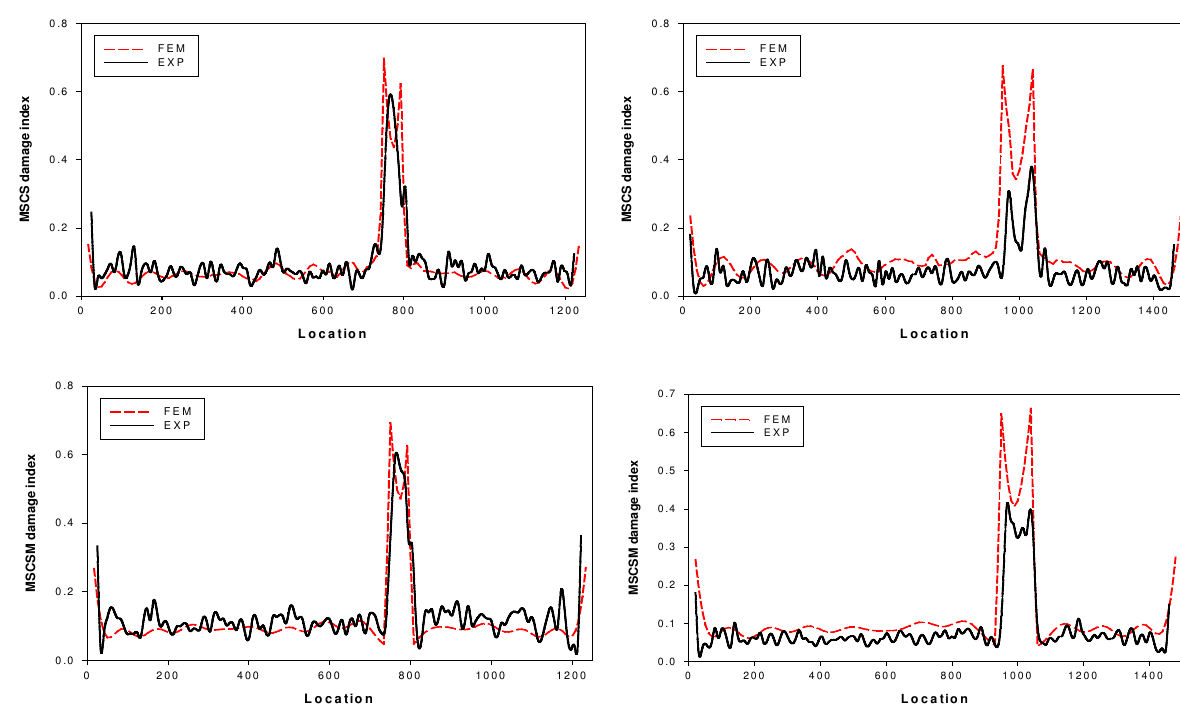
Fig 4. Damage detection methods for beams with CL boundary conditions; Beam1 – left; Beam 2 –